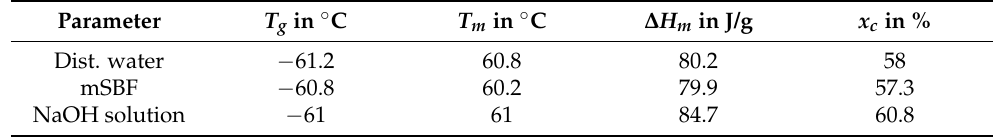
Table 3. Glass transition ( Tg ), melting temperature ( T m ), melting enthalpy ( ∆ H m ), and the calculated crystallinity ( x c ) of the fiber mats efPCL after two weeks immersion in dist. H 2 O, mSBF, and NaOH solution (pH 13) ( n =